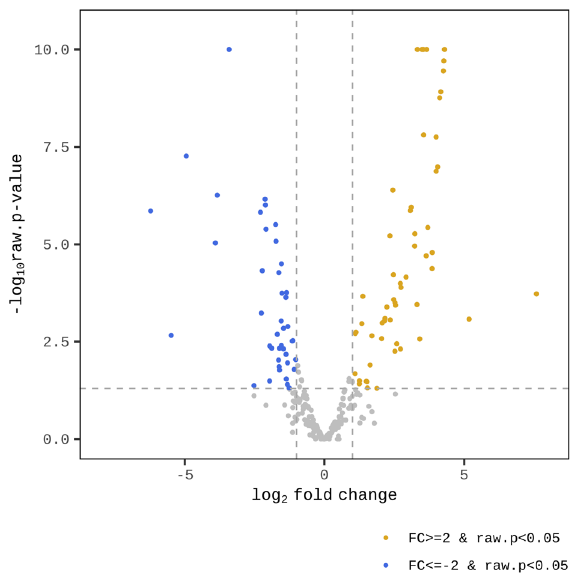
Figure 4. Volcano plot of the expression level of two groups. Log 2 fold change and p -value obtained from the comparison between two groups plotted as a volcano plot (X-axis, log 2 fold change; Y-axis, -log 10 p